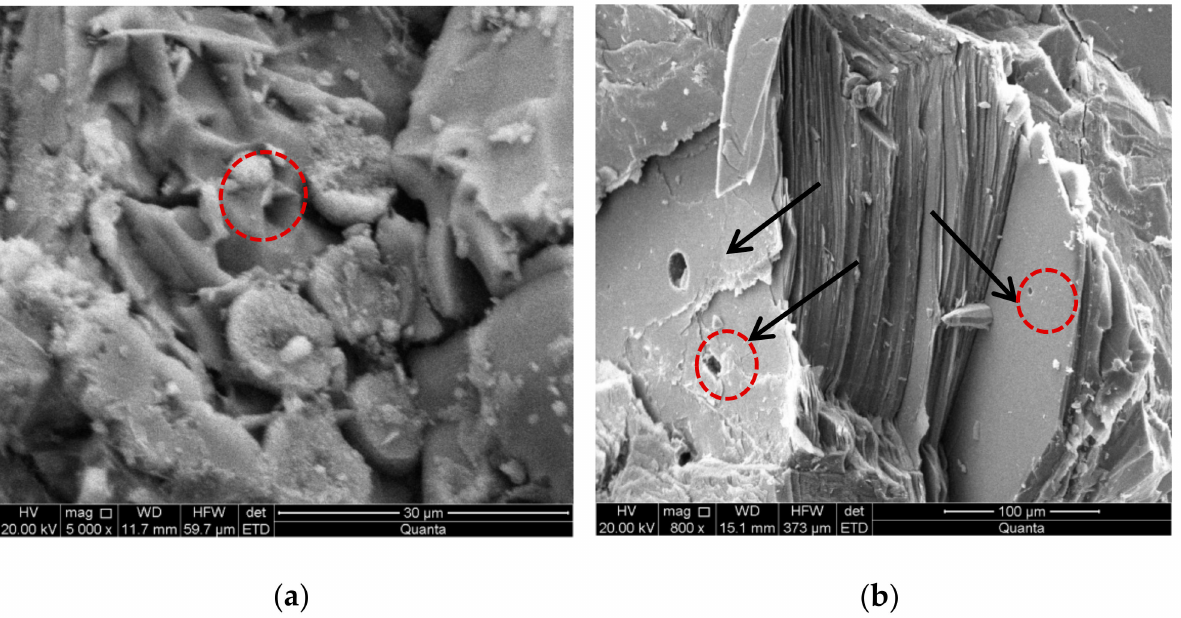
Figure 3. ( a , b ): Scanning electron microscopy observations of corrosion pores in a granite sample (S3) corroded by high concentration mud acid solution